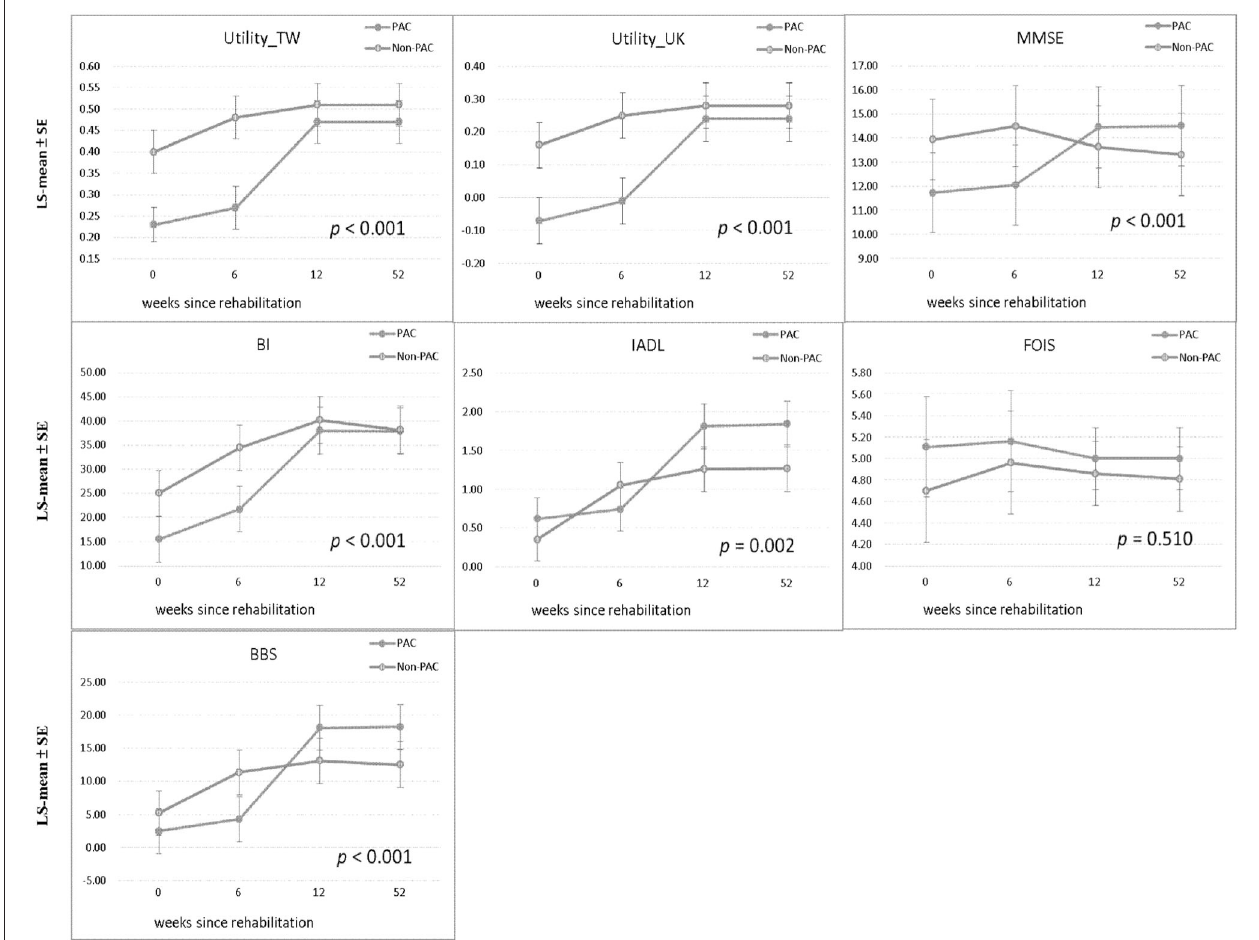
FIGURE 2 | Comparison of LS-mean ± SE of each functional status measure between PAC and non-PAC groups at baseline, weeks 6 and 12, and 1 year and comparison of trend in each functional status measure between the groups. Utility_TW, utility (Taiwan); Utility_UK, utility (United Kingdom); MMSE, Mini-Mental State Examination; BI, Barthel Index; IADL, Instrumental Activities of Daily Living Scale; FOIS, Functional Oral Intake Scale; BBS, Berg Balance Scale; PAC, postacute care; LS-mean, least squares mean; SE, standard error. P values for trend in each functional status measure between the groups